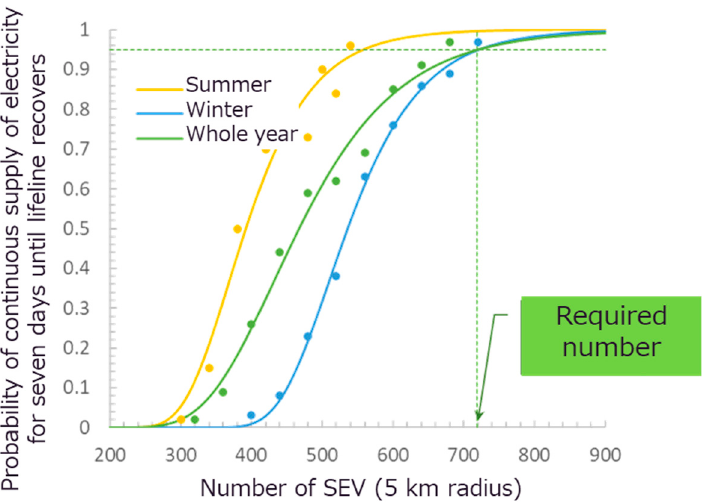
Figure 15. Number of SEVs vs. probability of continuous electricity supply for seven days, until the lifeline recovers (residential zone in Miyazaki).